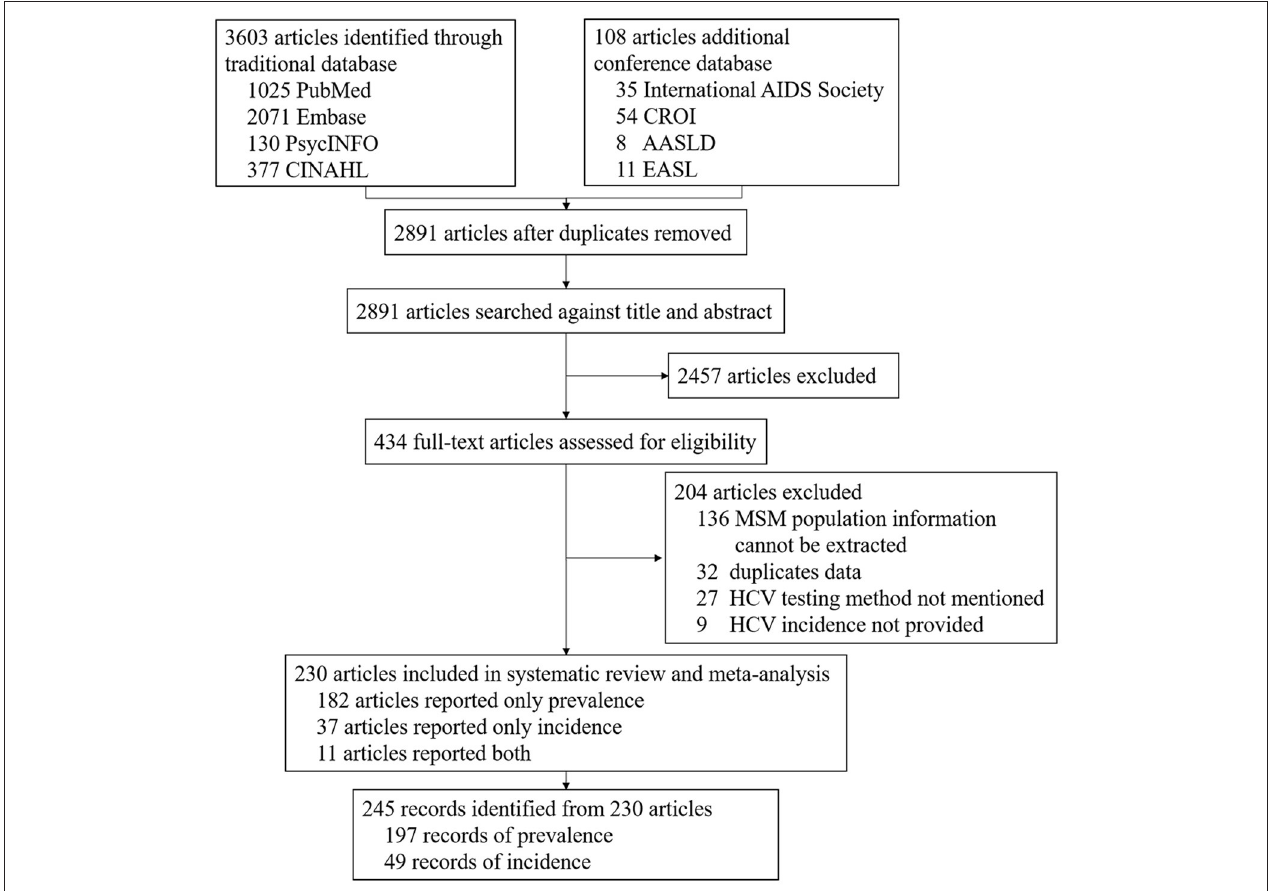
FIGURE 1 | Flowchart of studies selection